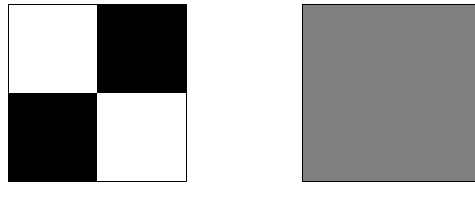
Figure 1: The graphons W 1 and W 2 from the example given before Lemma